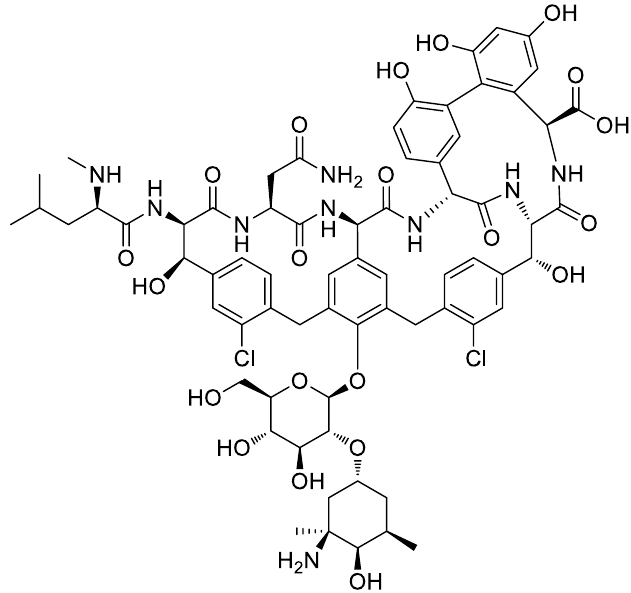
Figure 8. The chemical formula of vancomycin (free base).